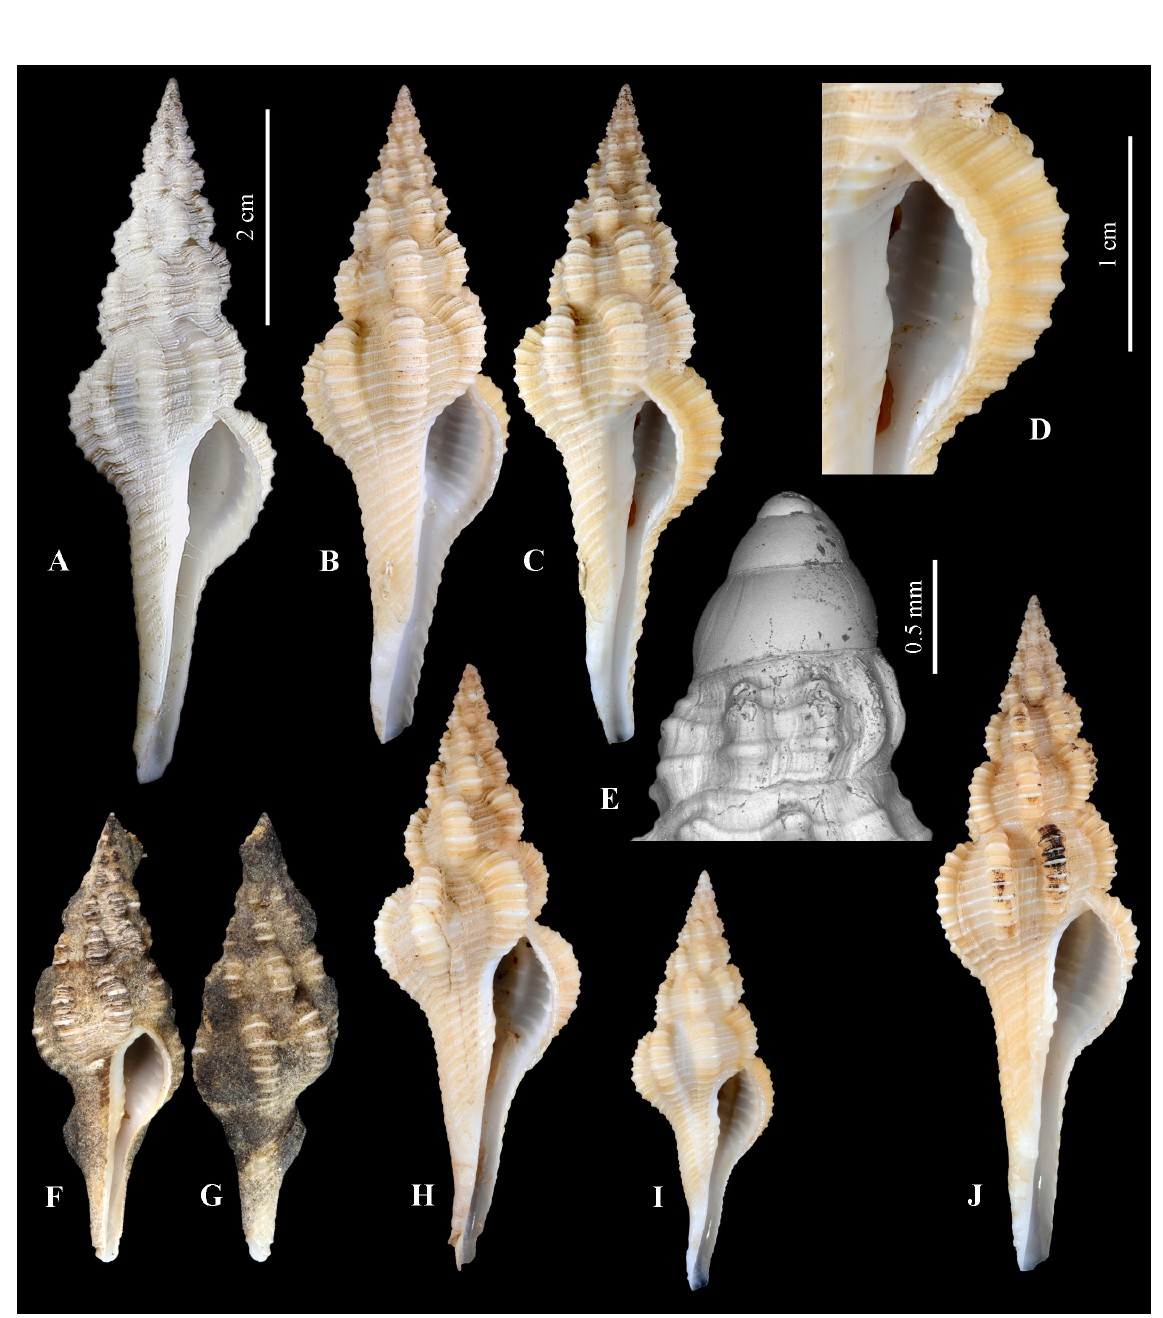
Fig. 5. Granulifusus jeanpierrevezzaroi (Cossignani, 2017) comb. nov. A . Holotype, SL 66.3 mm (MMM) (photo courtesy of T. Cossignani). B–D . Sequenced specimen, SL 62.2 mm (MNHN